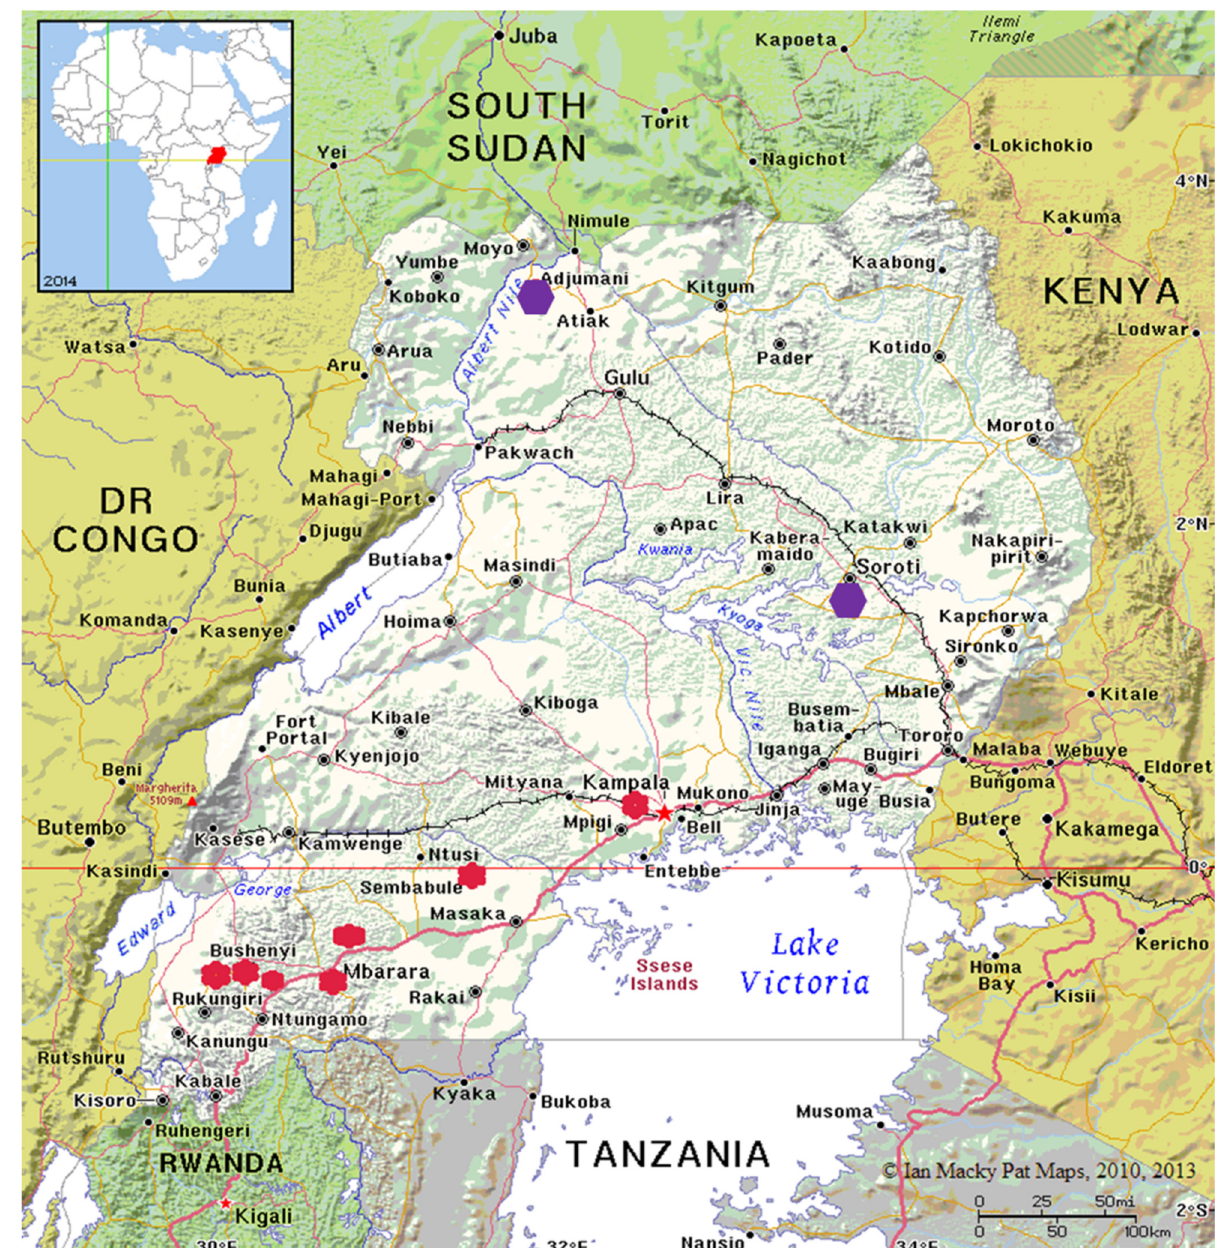
Figure 1. Map of Uganda showing the districts from which tick samples were collected. The red spots represent high acaricide presure area and the purple spot is for low acaricide presure area where the susceptible population was